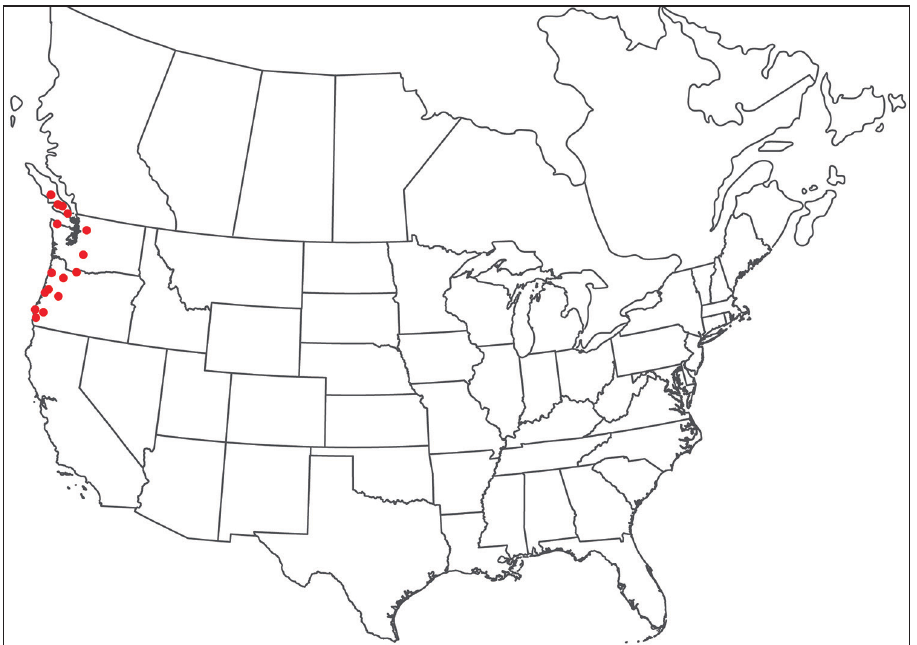
Figure 181. Torrenticola pacificensis sp. n.